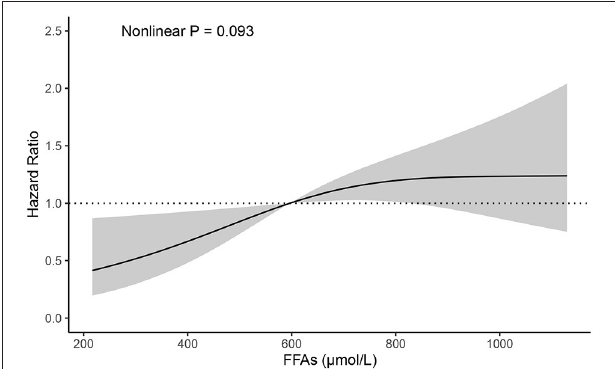
FIGURE 1 | Cubic spline depicting the association of FFAs with the incidence of all-cause mortality or HF rehospitalization, P non-liner = 0.093 (adjusted for age, sex, BMI, CAD, DM, hypertension, LVEF, NT-proBNP). BMI, body-mass index; CAD, coronary artery disease; DM, diabetes mellitus; LVEF, left ventricular ejection fraction; NT-proBNP, N-terminal pro brain natriuretic